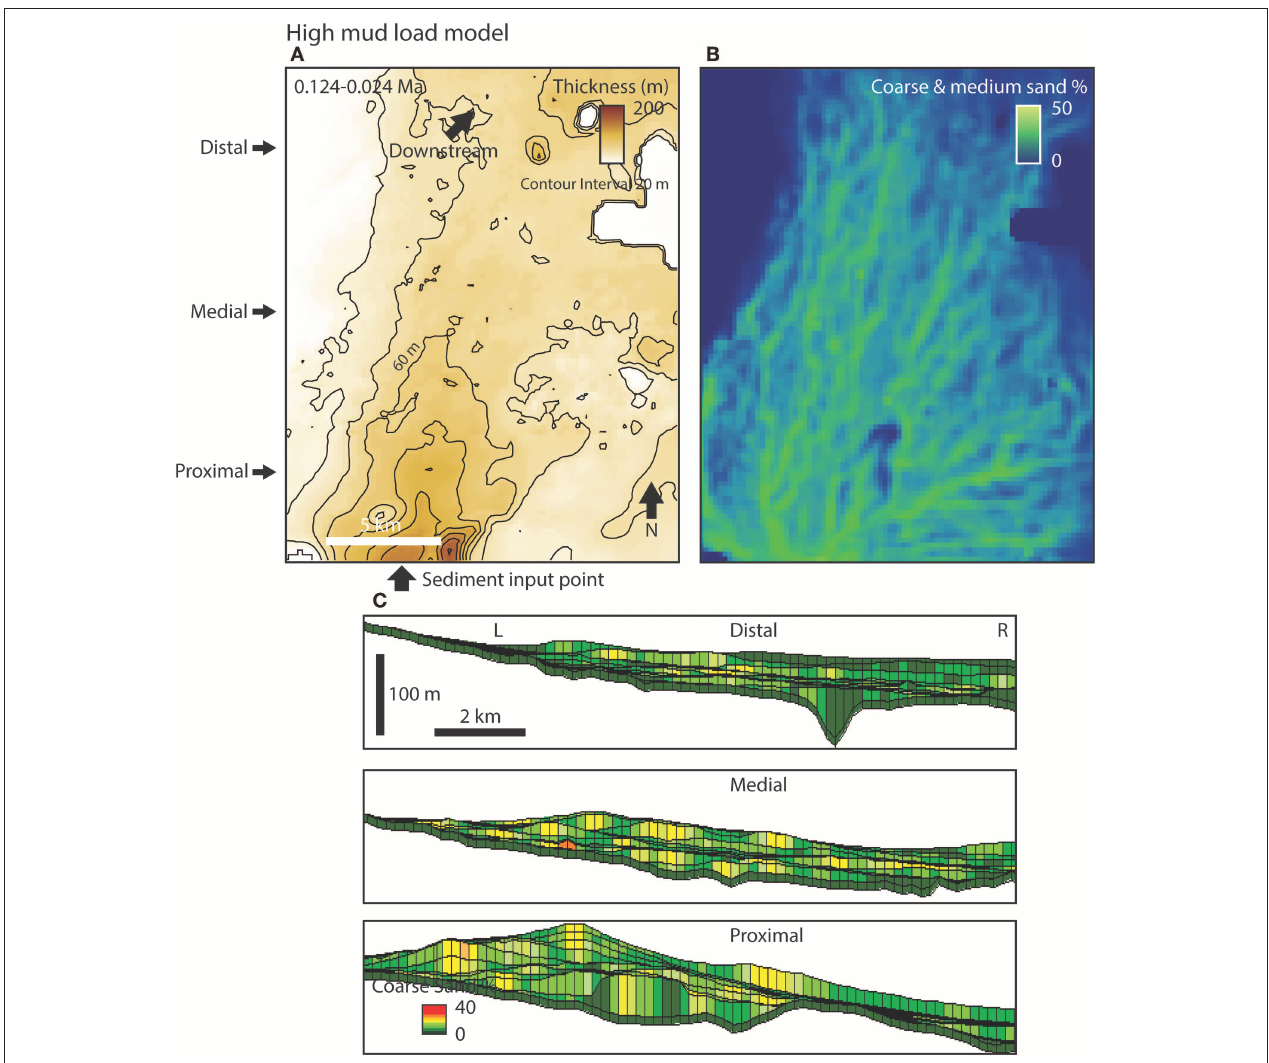
FIGURE 5 | (A) Isochore map of the high mud load model. (B) Coarse and medium sand percentage within the model. (C) Proximal, medial, and distal cross sections showing the coarse sand content in the model. Left (L) and right (R) orientations in cross sections are left and right in maps. Cross-section locations are indicated in part (A)